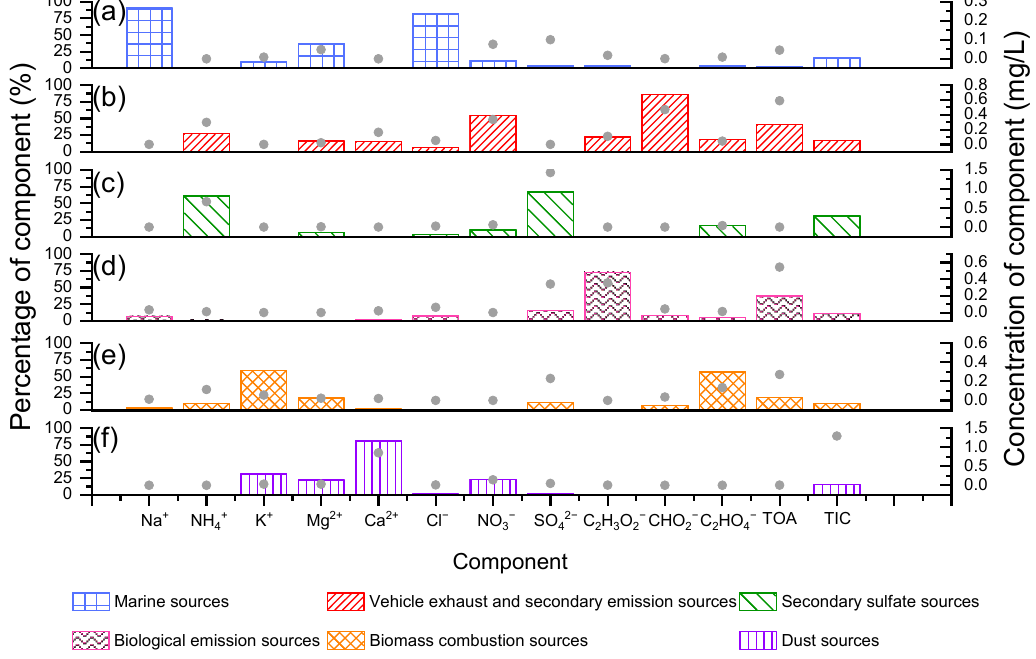
Figure 7. The percentages and concentrations of species in rainfall events in the six factors identified by PMF are illustrated. Total organic acids are represented by TOA, total ion concentrations are represented by TIC. The bar graphs corresponded to the left ordinate (percentage of component), and the grey points corresponded to the right ordinate (concentration of component). Six factors at this site were identified: ( a ) marine sources, ( b ) vehicle exhaust and secondary emission sources, ( c ) secondary sulfate sources, ( d ) biological emission sources, ( e ) biomass combustion sources, and ( f ) dust sources.